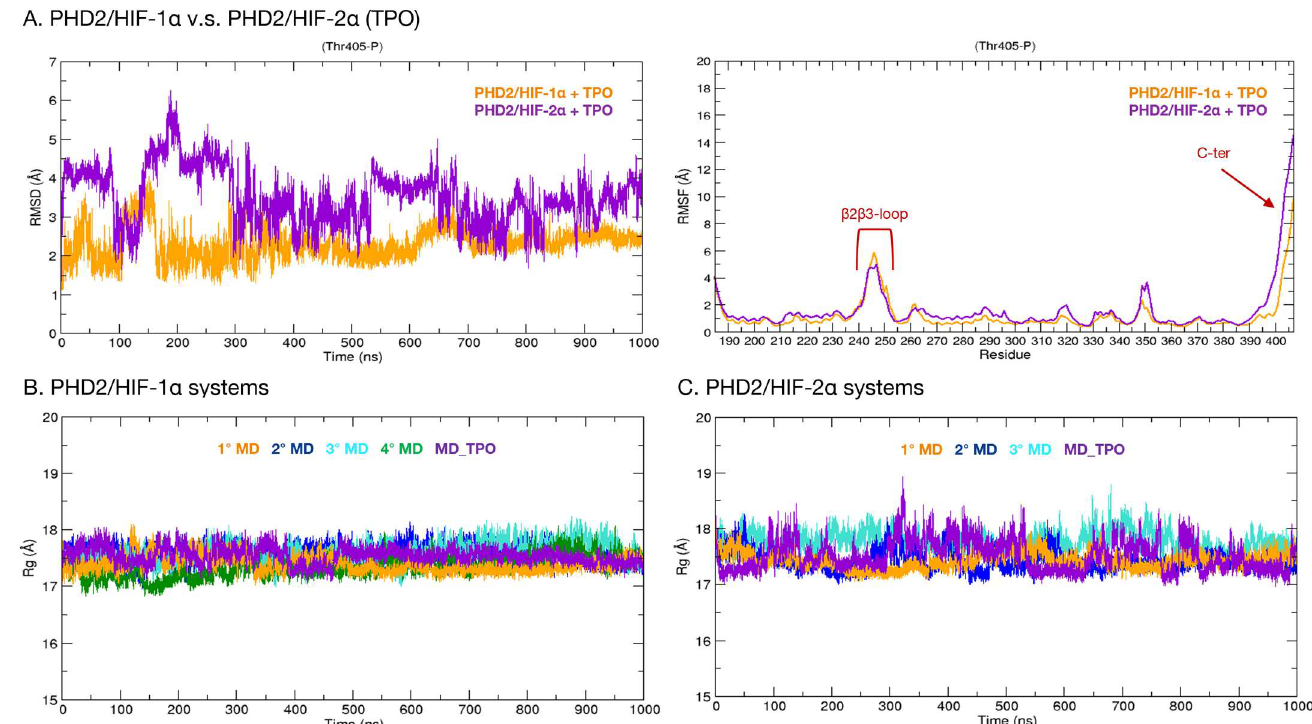
Figure 5. Comparison of RMSD, RMSF, and Rg plots of PHD2/HIFs-a complexes with Thr405-P (TPO). ( A ) PHD2/HIF-1α + TPO (orange) and PHD2/HIF-2α + TPO (purple). ( B ) Comparison of the gyration radius between all systems of the PHD2/HIF-1α complex: first simulation (orange), second run (blue), third (turquoise), fourth (green), and simulation with phosphorylation (purple). ( C ) Comparison of gyration radii among all systems of the PHD2/HIF-2α complex: first simulation (orange), second simulation (blue), third simulation (turquoise), and simulation with phosphorylation (purple).